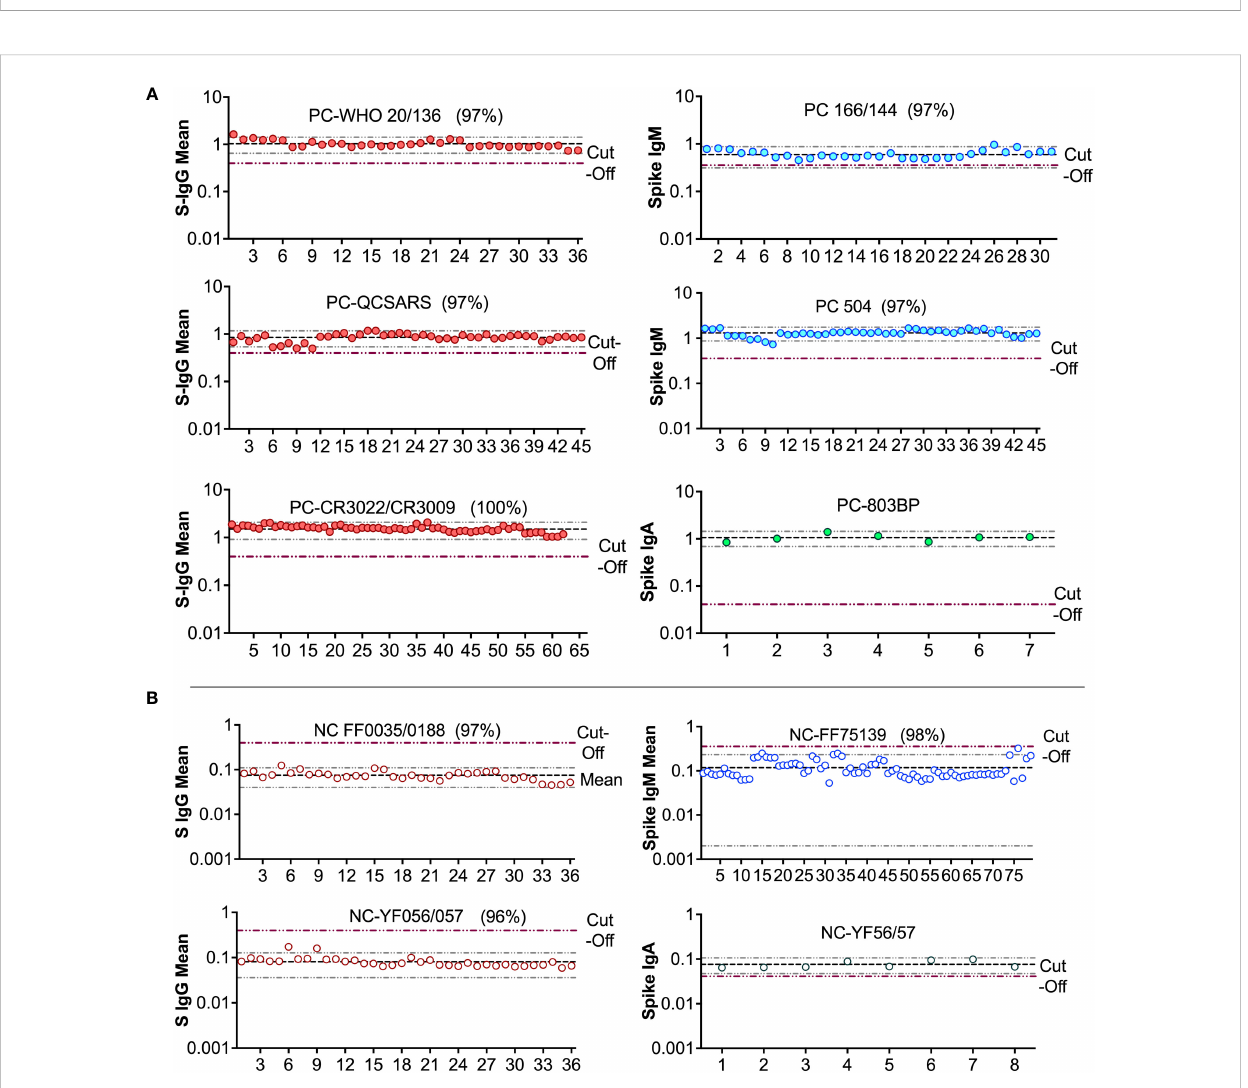
FIGURE 8 Levy Jennings charts plotted from a WHO international standard panel (20/136) and in-house local controls (A) : Levy-Jennings charts to track consistency of the in-house and international positive controls. (B) shows Levy-Jennings charts demonstrating the range of standard deviations from mean OD450 over time, with repeated use of local and WHO standard negative controls.